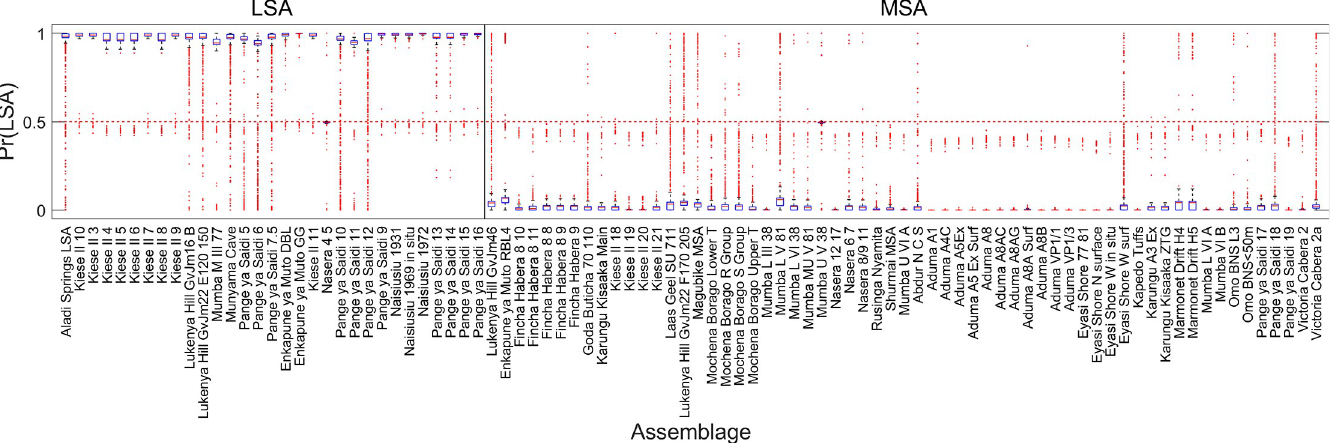
Fig 7. Boxplots of classification probabilities (2-way). Classification probabilities are derived from each of 1,000 neural networks in the 2-way analysis. Red lines show medians, boxes extend to the inter-quartile range, and whiskers show 95% of the distribution. Outliers are shown as red dots. For correct classification, values for the LSA assemblages should be close to 1 and those for the MSA assemblages close to zero.